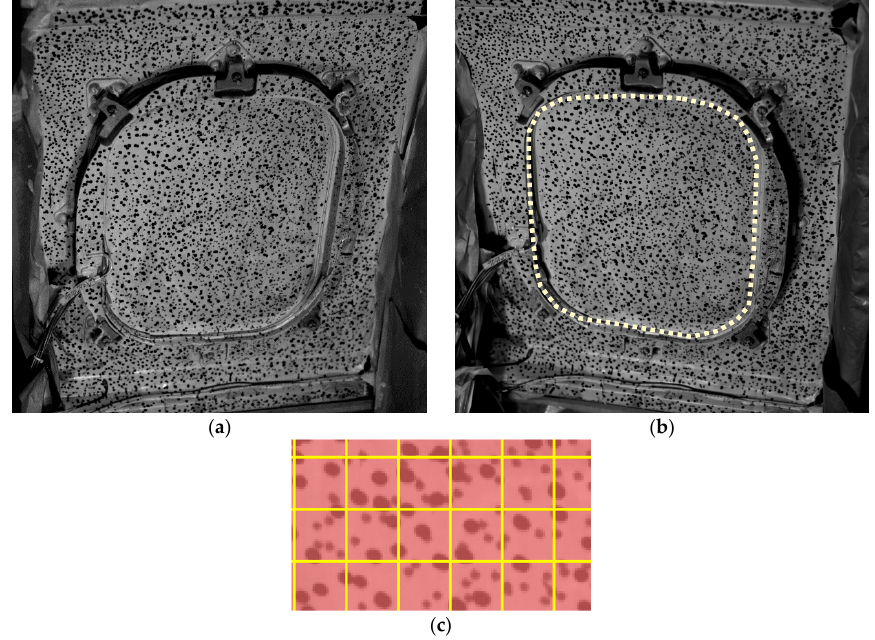
Figure 10. Images of the window from the cameras point of view. ( a ) Left-hand camera; and ( b ) right-hand camera. Dotted lines represent the area analyzed using shape descriptor image decomposition; ( c ) sample of the facets grid.